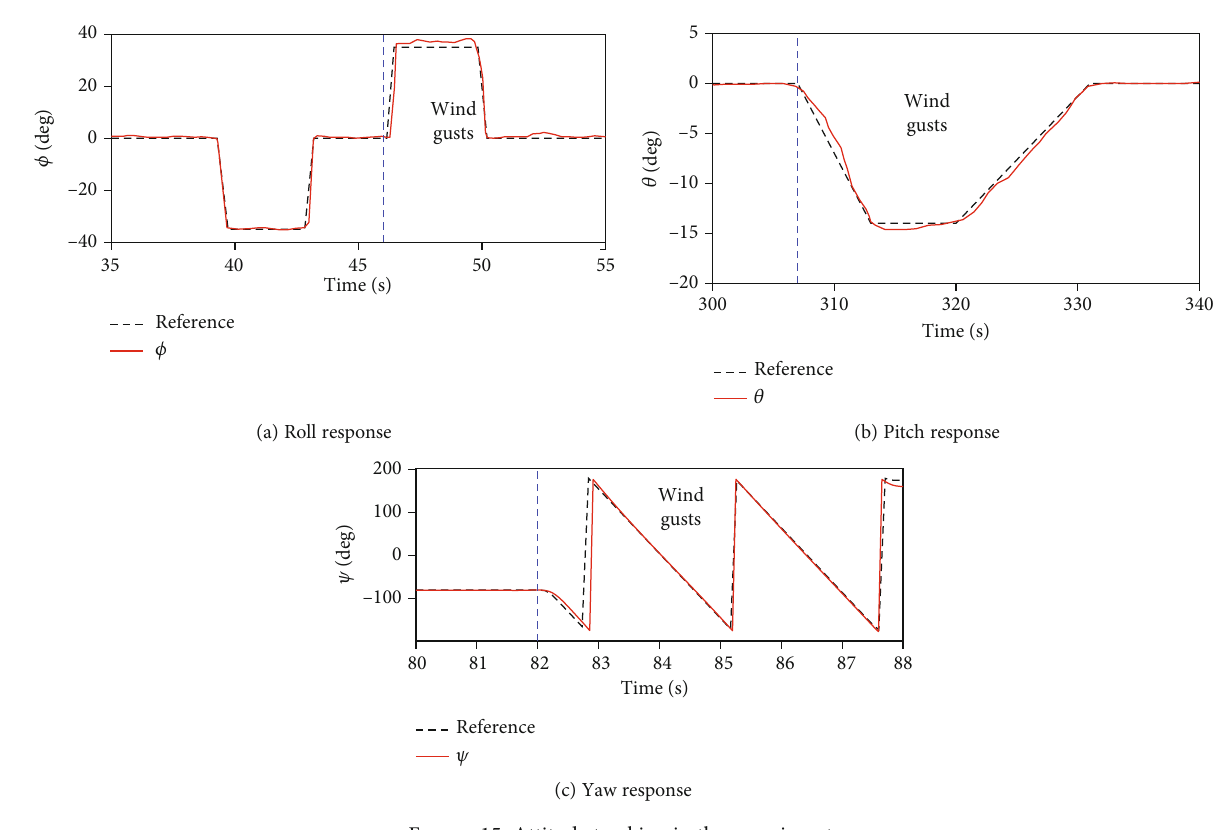
Figure 14: Snapshots of attitude tracking.